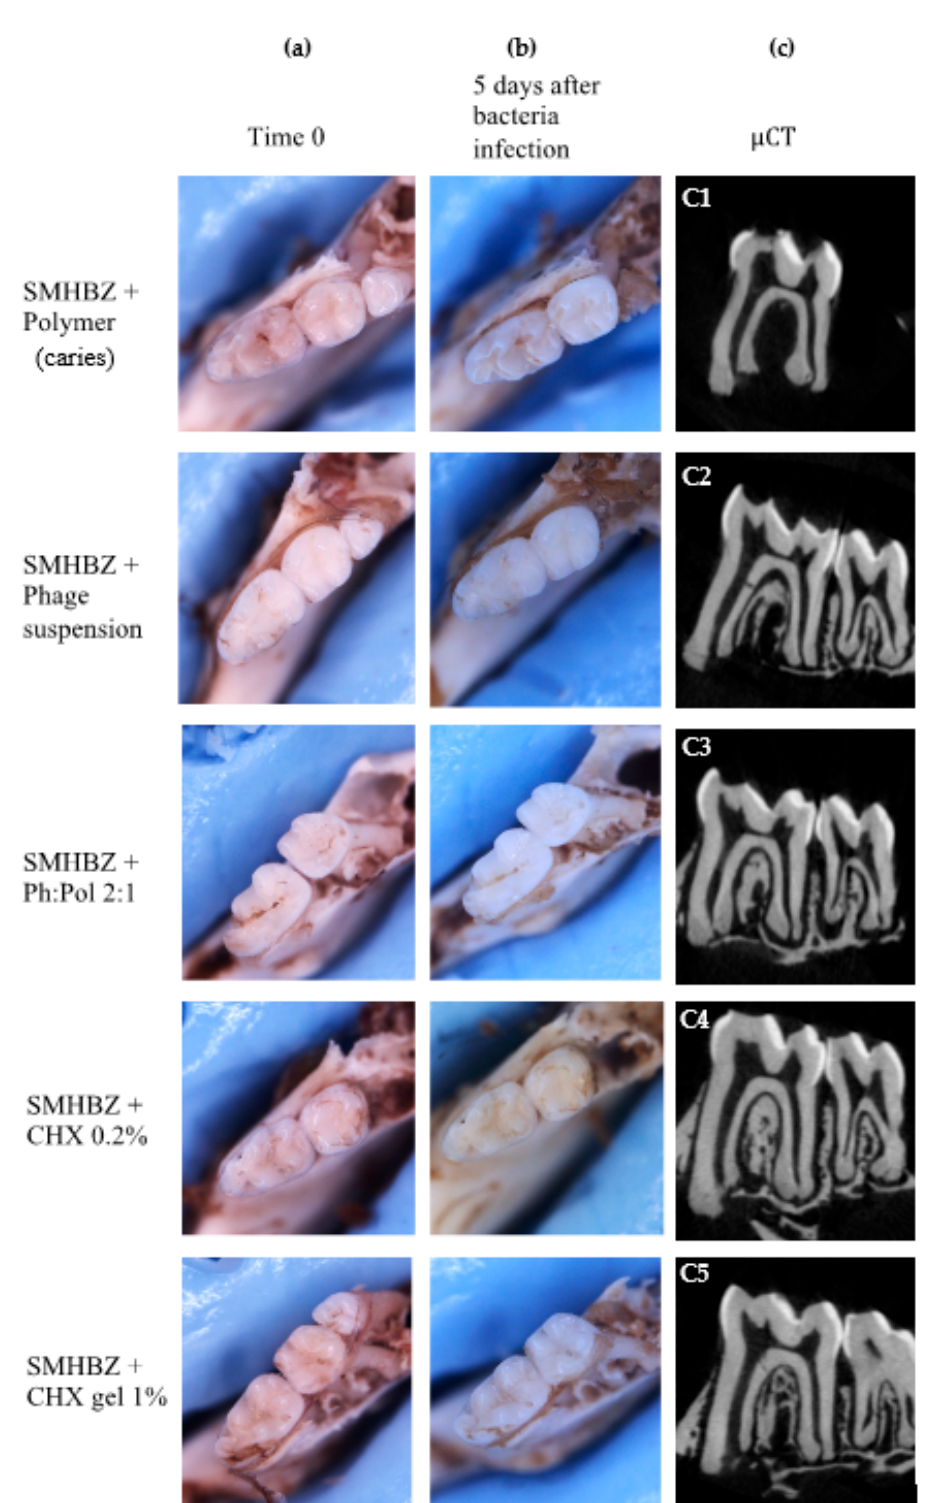
Figure 3. Clinical and radiographic evaluation of caries lesions after 5 days in a caries-promoting environment. Representative clinical images ( a ) before and ( b ) after caries induction using high- sucrose media and cariogenic bacteria (SMHBZ) for 5 days. ( c ) Representative radiographic image after caries induction period.